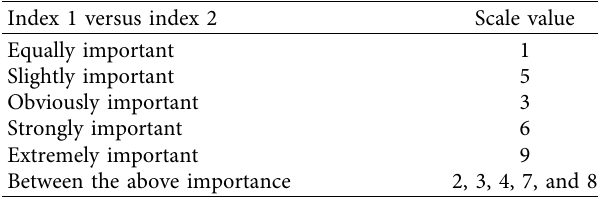
Table 1: Importance of scale values of indicators.